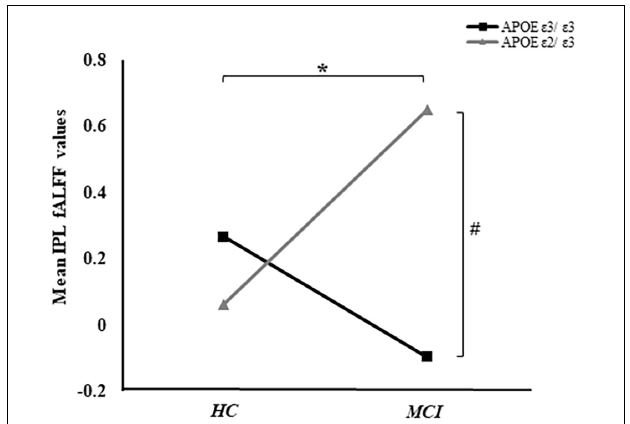
FIGURE 3 | The “APOE × disease” (interaction) effects between APOE and cognitive status were shown. In addition, the average fALFF values in the IPL of groups were demonstrated. *Represents p < 0.05 between MCI and HC. # Represents p < 0.05 between APOE ε 3/ ε 3 and APOE ε 2/ ε 3 in MCI.